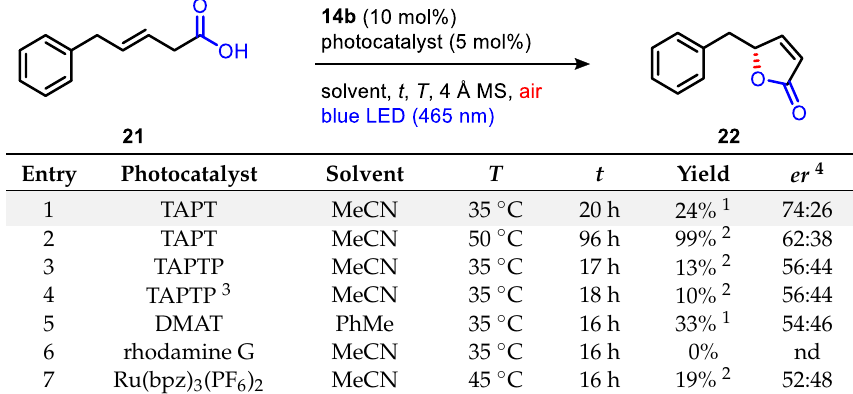
Table 2. Screening for proper reaction conditions for the enantioselective aerobic lactonization of 5-phenylpent-3-enoic acid ( 21